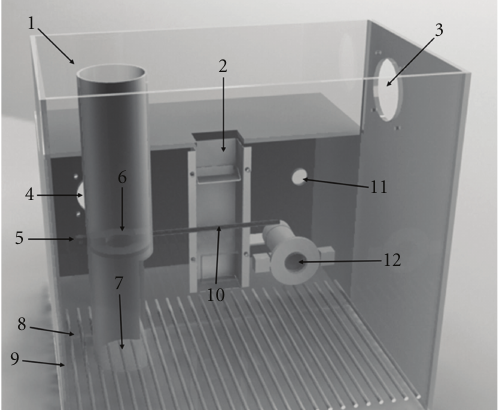
Figure 2: Internal view of the equipment. 1: weight lifting cylinder; 2: automatic feeder; 3: fan; 4: sound device; 5: axis measurement; 6: lifting ring; 7: support base; 8: copper bars; 9: drawer; 10: lifting bar; 11: light device; 12: nose